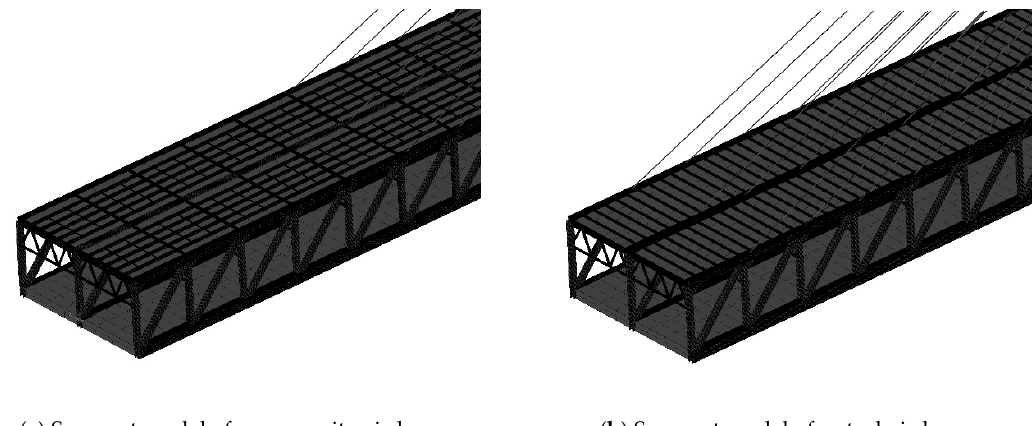
Figure 13. The 3D and equivalent “fish-bone models” of the case bridge.